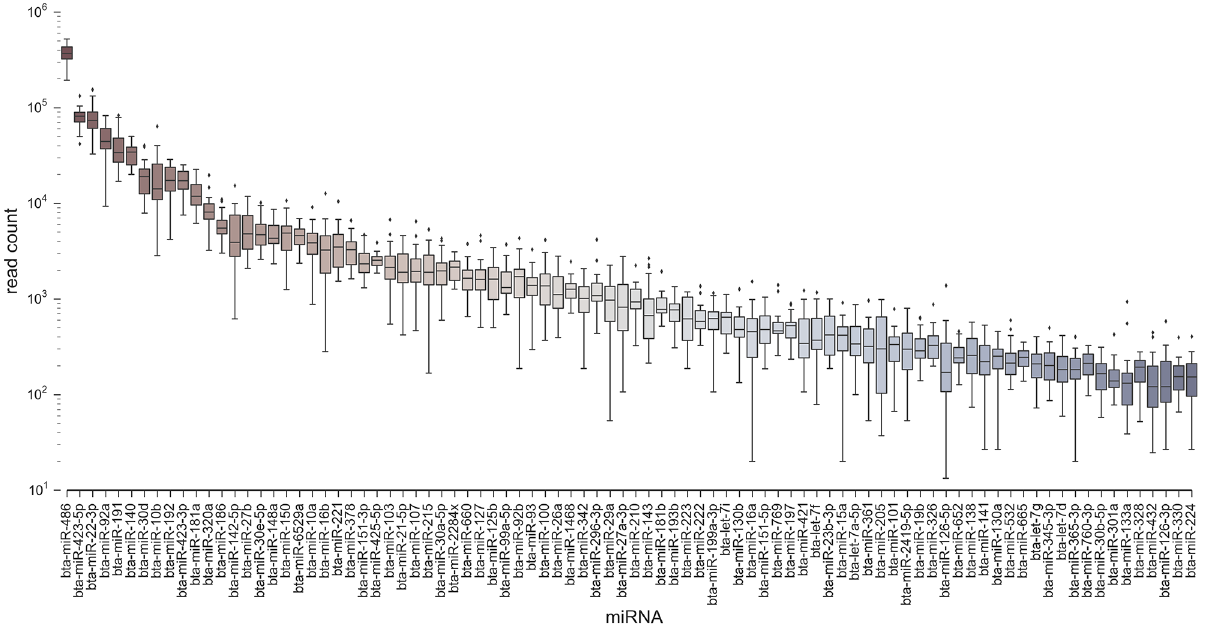
Fig 3. Read count distributions in all samples for top known miRNAs found by miRDeep2.